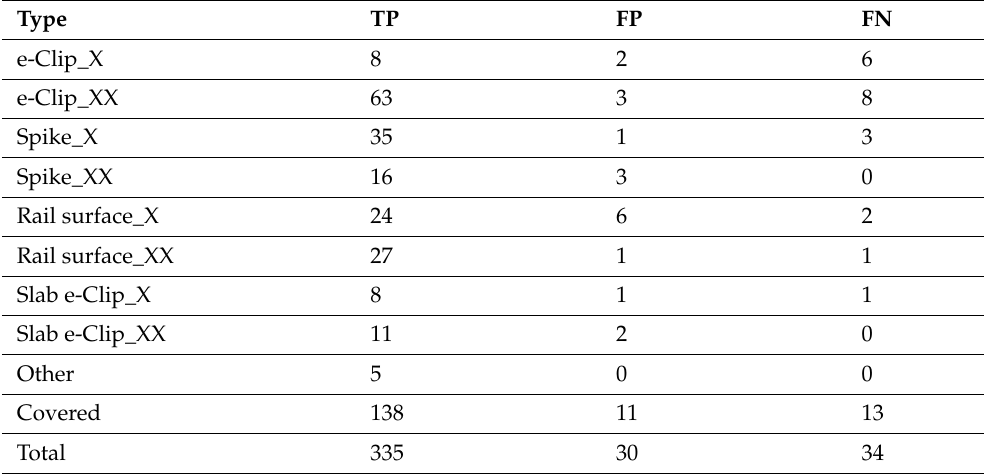
Table 10. YOLOv4-Tiny training results for each defective type in the top